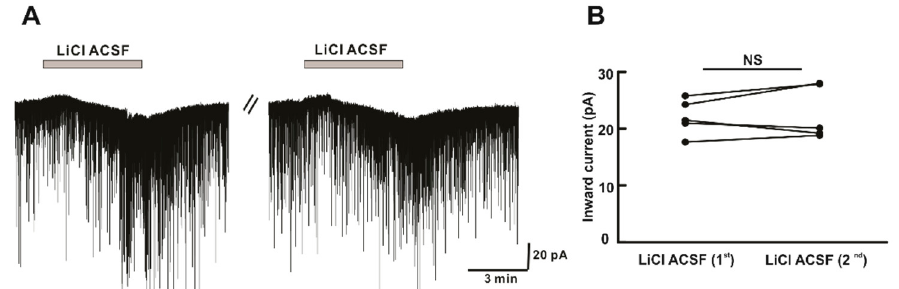
Figure 5. Li + induces repeatable inward currents on hPOA neurons. ( A ) A representative current trace showing repeatable inward currents on hPOA neuron induced by perfusion of LiCl ACSF.